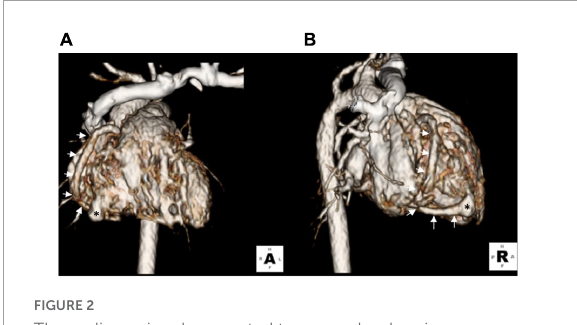
lageniform coronary artery fistula (asterisks) arising from the RCA (arrows) drained into the inferior wall of the RV. (A) Anterior-posterior view. (B) Right lateral